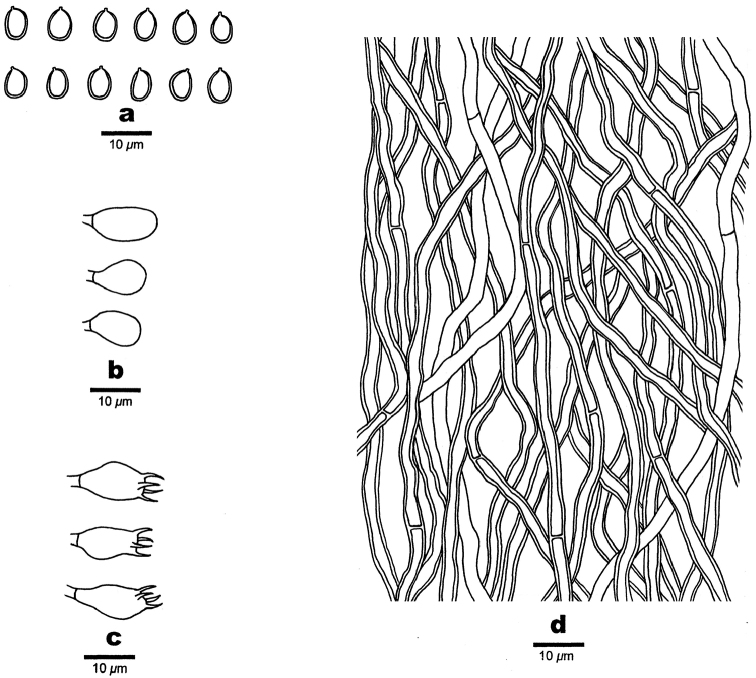
Microscopic structures of Fomitiporella
mangrovei. a Basidiospores b Basidioles c Basidia d Hyphae from trama.